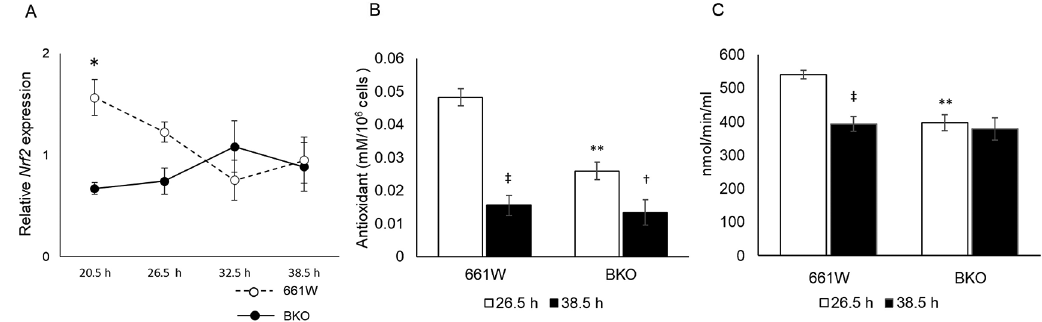
Figure 4. Circadian variation of Nrf2 mRNA expression and time dependent variation of antioxidant capacity and GPx activityin 661Wcells. (A) Circadian expression of Nrf2 was rhythmicin 661W cells but not in BKO cells (two- wayANOVA, p <0.05betweengroupsontheTukeymultiplecomparisontest,*p<0.05,one-wayANOVA661Wcells: p < 0.05; BKO cells: p > 0.05, n = 6). (B) Time dependent variation in antioxidant capacity was observed in both WT and BKOcells,althoughantioxidantcapacityofBKOcellswaslowerthanof661Wcellsat26.5h(two-wayANOVAfollowed by Tukey multiple comparison test, n = 6, ** p < 0.01 661W cells vs. BKO cells, † p < 0.05, ‡ p < 0.01 26.5 h vs. 38.5 h). (C) Time dependent variation of GPx activity was observed in WT 661W cells but not in BKO cells (two-way ANOVA